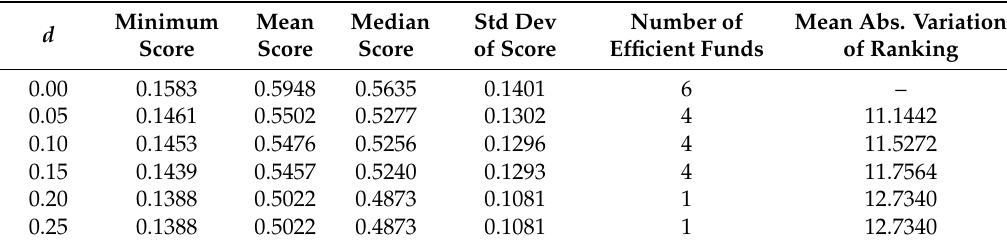
Table 3. Main results for the VW restrictions with constraints on all DMUs in the case of symmetric bounds and T = 7. Summary statistics on the performance scores (minimum, mean and median values, standard deviation), number of efficient funds and mean absolute variation (divided by 2) of the ranking positions.